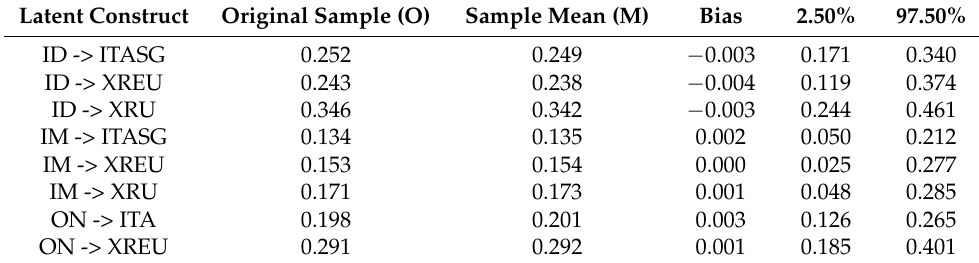
Table 6. Hetero-Trait-Mono-Trait (HTMTinference).